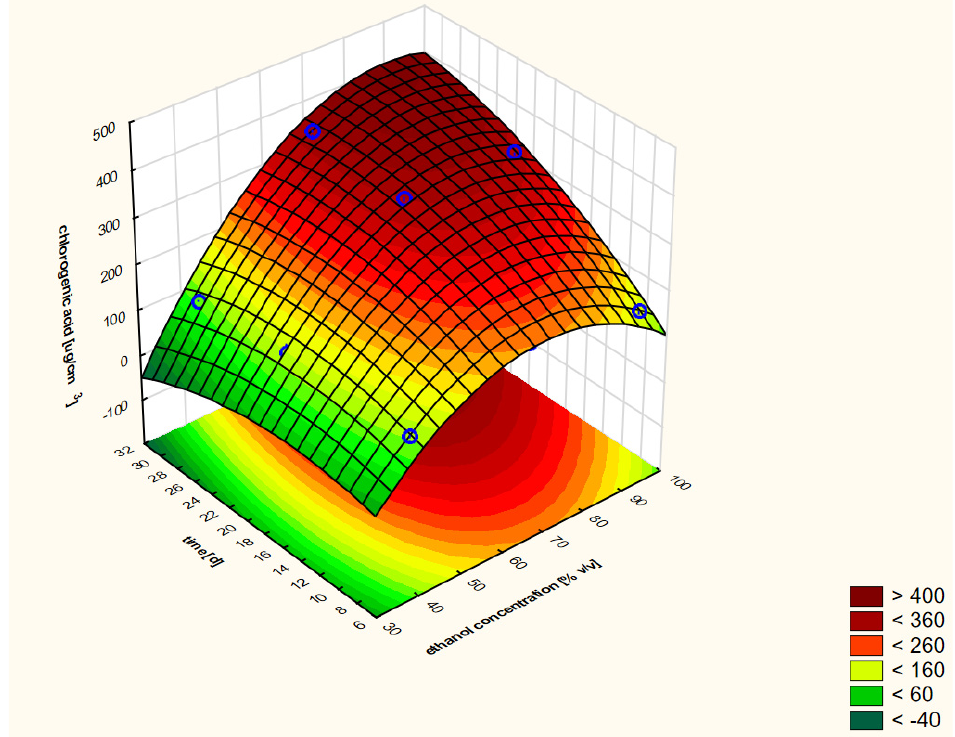
Figure 3. Model of the response surface (3D) regarding the contents of chlorogenic acid in ethanol extracts of elderberry flowers obtained from fresh raw material that was initially treated with warm ethanol at 50 °C. The 3D model is shown only once for a better understanding of the RSM concept.